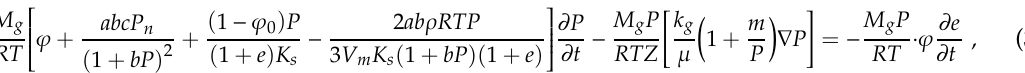
Table 1. Material parameters of gas-bearing coal. Parameter Name